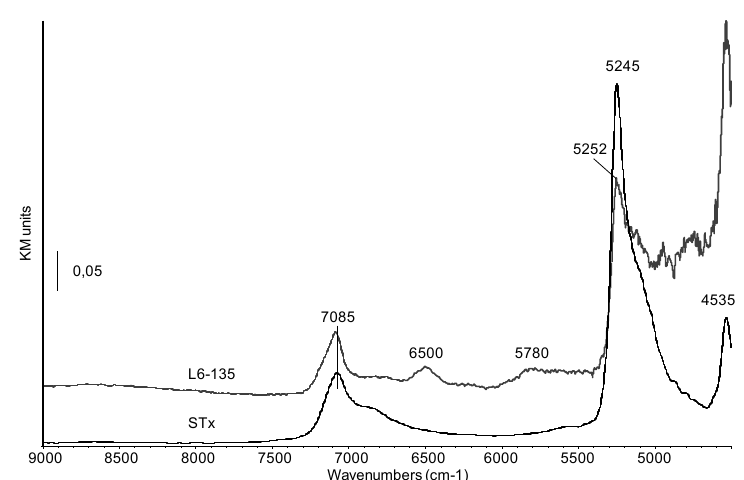
Figure 7. Di ff use Reflectance NIR spectra of STx and organo-clay L6-135. Figure 7. Diffuse Reflectance NIR spectra of STx and organo-clay L6-135.